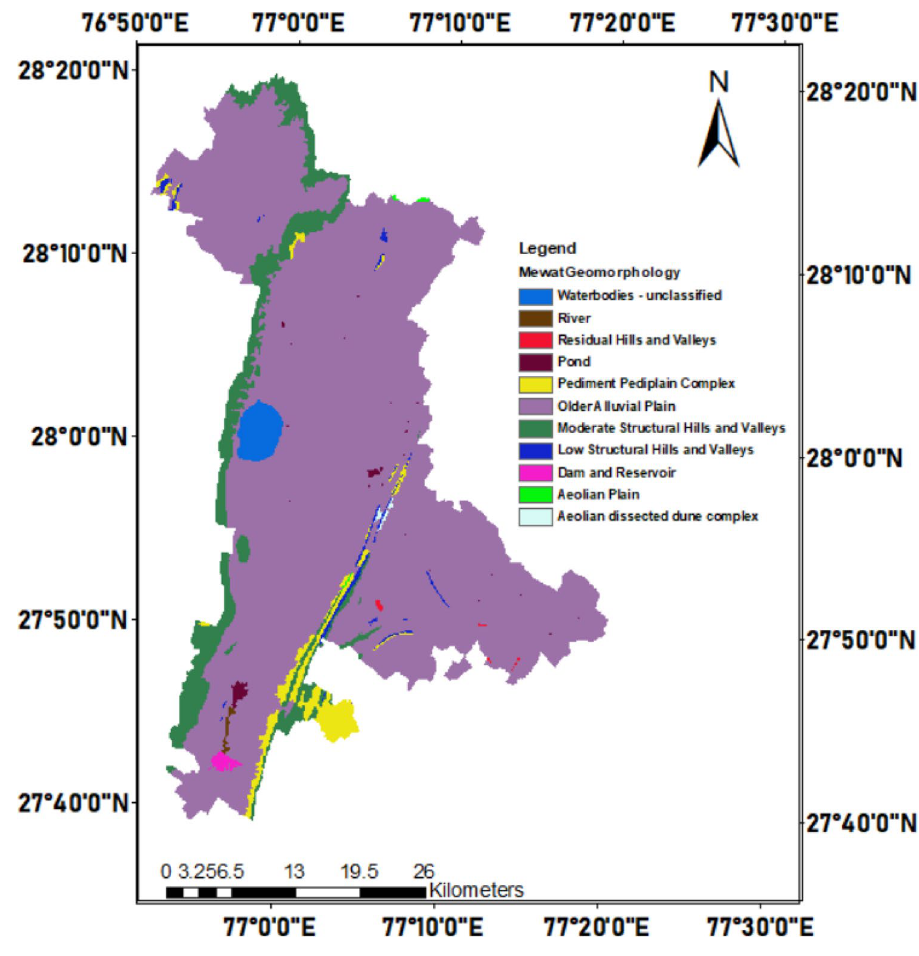
Fig. 5 Geomorphology map of study